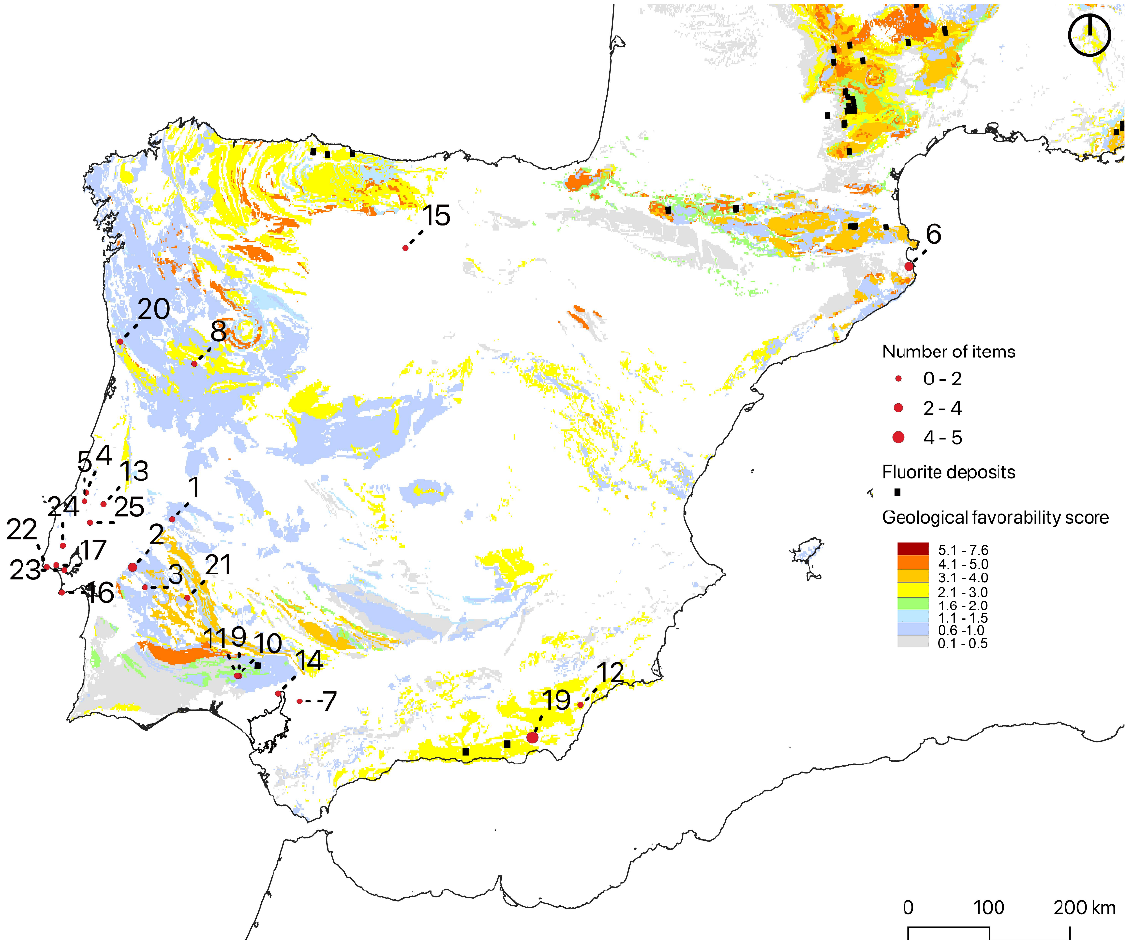
Figure 1. Iberian late prehistory sites and materials cited and studied in the text, compared with fluorite geological occurrence in the Iberian Peninsula. 1. Anta Grande da Comenda da Igreja. 2. Anta Grande do Zambujeiro. 3. Anta dos Penedos de São Miguel. 4. Cabeço da Ministra. 5. Casa da Moura. 6. Cau de l´Olivar d´en Margall. 7. Cueva del Vaquero. 8. Dolmen de Areita. 9. El Pozuelo 1. 10. El Pozuelo 5. 11. El Pozuelo 7. 12. Fuente Álamo. 13. Gruta da Marmota. 14. La Emisora (Valencina). 15. La Velilla. 16. Lapa do Bugio.